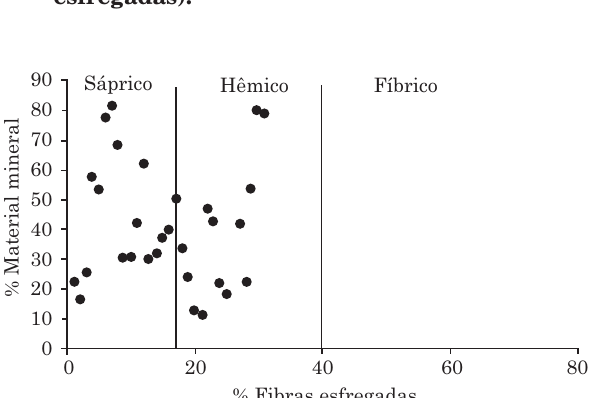
Figura 6. Relação entre os teores de fibras esfregadas (%v/v) e o teor de material mineral